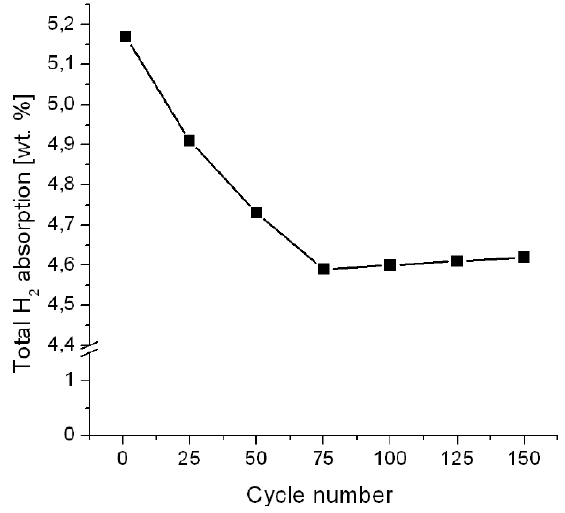
Figure 16. The total hydrogen absorption capacity for MgH obtained from PCT curves after a specified number of cycles at 325 °C. Adapted from